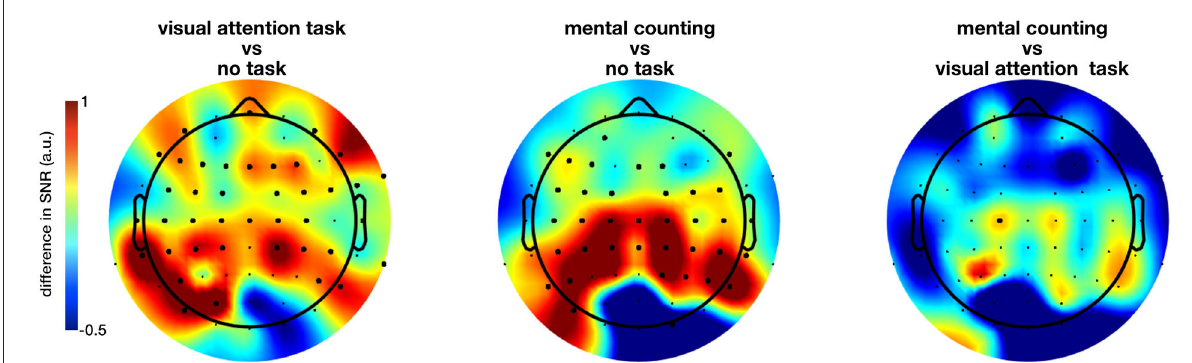
FIGURE3 Difference in the gamma entrainment signal-to-noise ratios ( 1 SNR) of regular-flickering conditions across subjects. The electrodes at which a statistical significance between conditions is detected are marked with thick dots. The significant difference between conditions with and without cognitive task are always in the anterior regions with visual task being more spread to the centro-frontal areas and non-visual task to the parietocentral regions. Furthermore, even though not statistically significant, one can see that the no-task condition consistently evokes stronger entrainment in the occipital regions in comparison with task conditions.